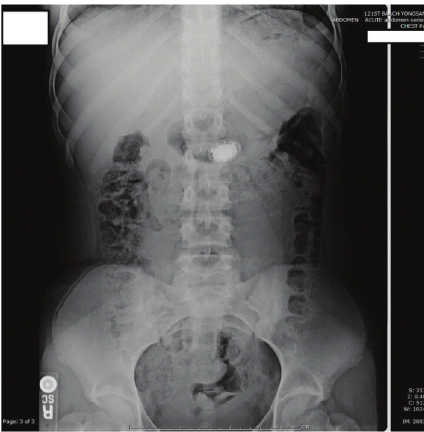
Figure 1: Supine abdominal X-ray showing watch in the stomach.